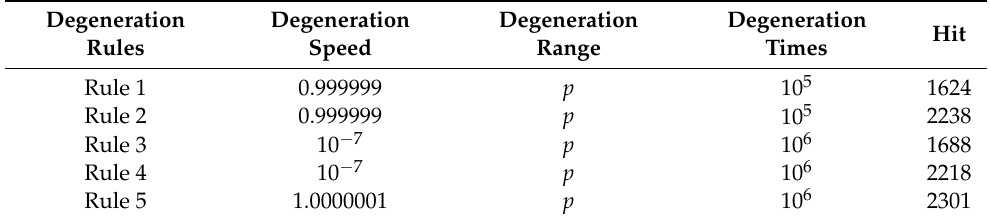
Table 9. Maximum number of low-probability password hits with different degeneration